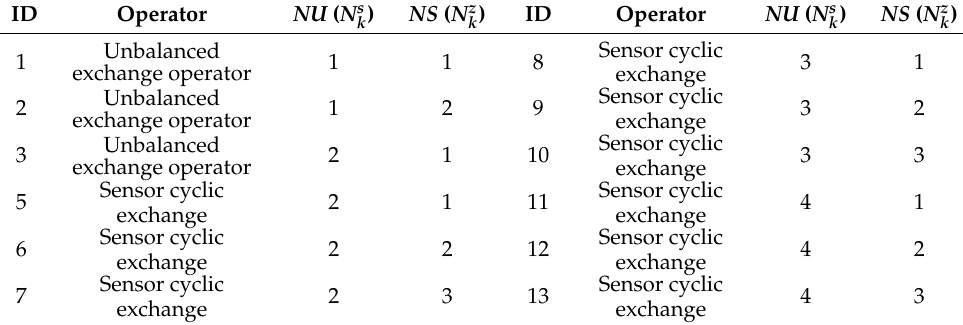
Figure 2. An example of a sensor cyclic exchange operator.